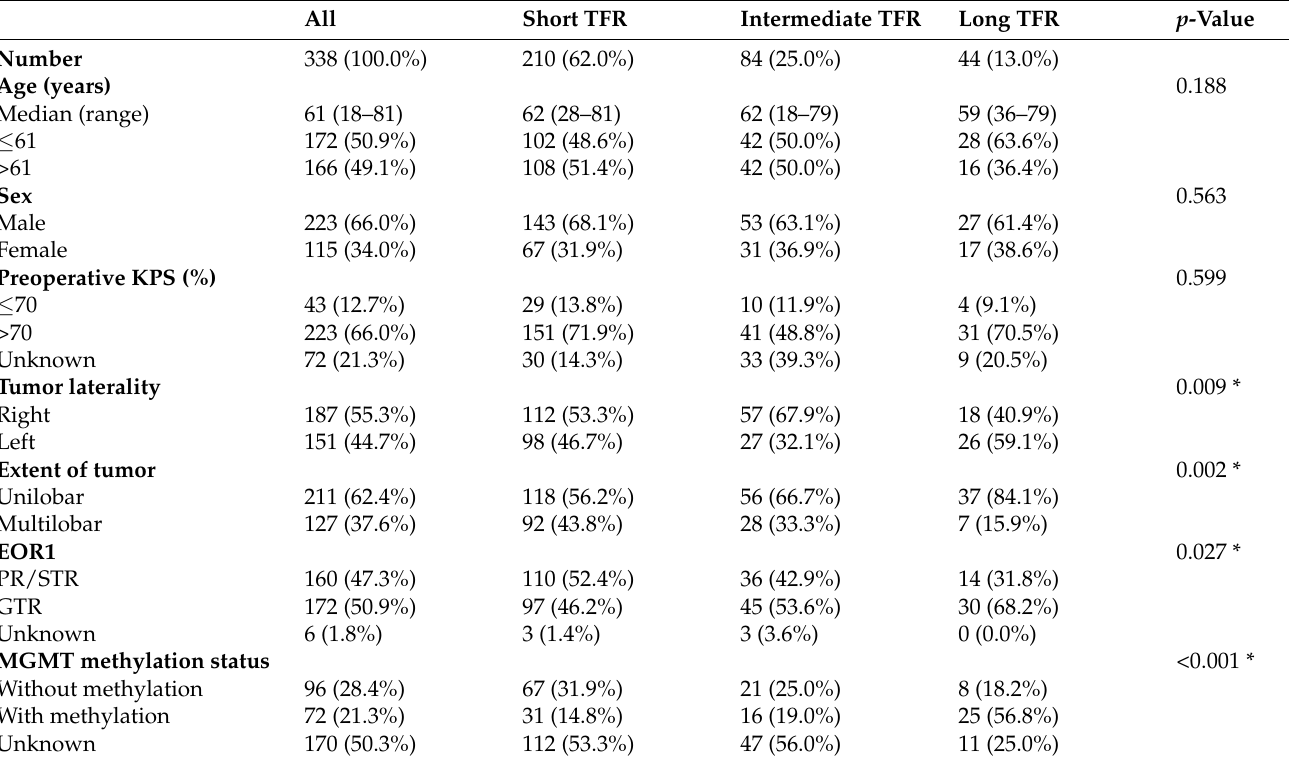
Table 1. Demographic and clinical characteristics of IDH-wildtype GB patients with a first relapse af- ter TMZ-based chemoradiotherapy. Patients were stratified according to TFR: short TFR ( ≤ 6 months), intermediate TFR (7 to 17 months) and long TFR ( ≥ 18